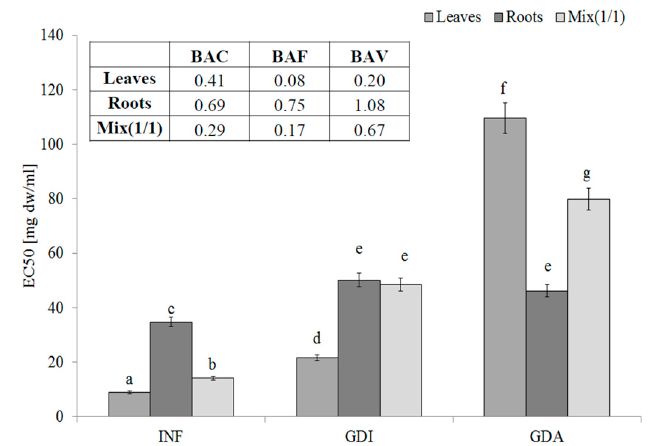
Figure 2. Xanthine oxidase-inhibitory potential of extracts from the leaves and roots of S. aloides .